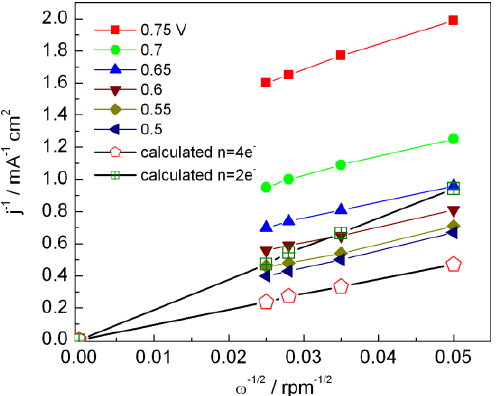
Figure 4. Levich-Koutecky plots corresponding to measured data of Pd/C (from Figure 3).